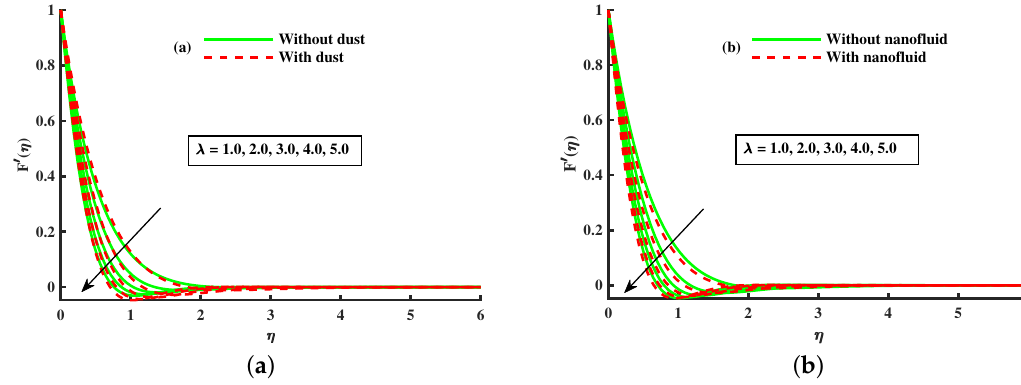
Figure 17. Fluctuation of λ on F (cid:48) ( η ) ( a ) and effect of λ on F (cid:48) ( η ) ( b